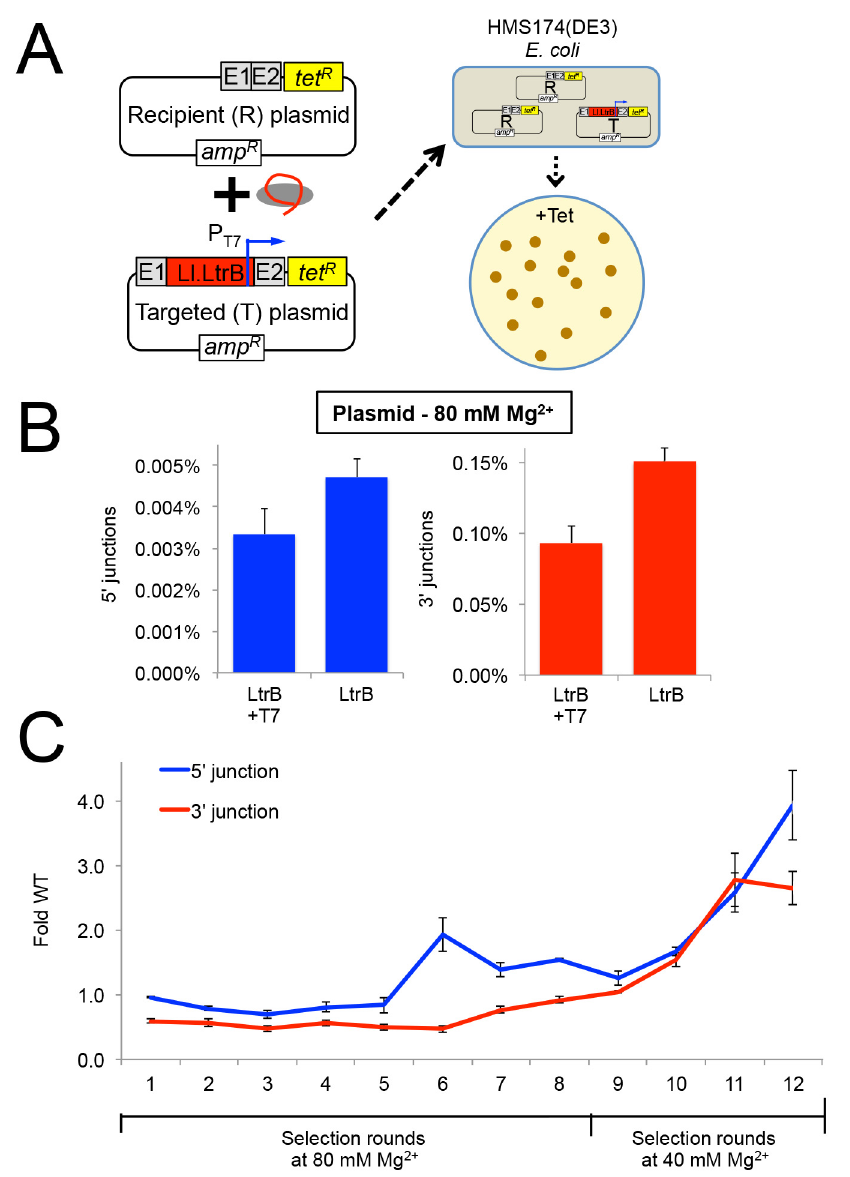
Fig 6. Selection of Ll.LtrB group II intron for retrohoming within HEK-293 cells at different MgCl 2 concentrations. (A) Diagram of plasmid-based selection for retrohoming in human cells. The three Ll.LtrB expression plasmids, including a derivative of pLl.LtrB in which the expressed intron carries a phage T7 promoter sequence in DIVb, were transfected into HEK-293 cells along with recipient plasmid pBRRQ, which contains the wild-type Ll.LtrB target site cloned upstream of a promoterless tet R gene. After incubating the cells in culture medium supplemented with 80 or 40 mM Mg 2+ for 24 h, plasmids were isolated and electroporated into E . coli HMS174( λ DE3), which was then plated on LB-agar containing tetracycline. Plasmids were isolated from scraped E . coli colonies, and introns that had retrohomed into the target site were amplified by PCR using primers that flank the intron and recloned into pLl.LtrB for the next round of selection. (B) Ll.LtrB introns carrying a phage T7 promoter in DIVb have ~70% wild-type retrohoming efficiency in plasmid targeting assays in HEK-293 cells. The bar graphs show retrohoming frequencies assayed by Taqman qPCR of 5 ’ - (blue) or 3 ’ - (red) integration junctions in DNA extracted from adherent HEK- 293 cells after 24-h incubation in culture medium supplemented with 80 mM Mg 2+ . Values are the mean for two or three separate transfections on the same day, with the error bars indicating the SEM. (C) The Ll.LtrB intron was evolved for retrohoming into plasmid targets within HEK-293 cells via eight cycles of selection